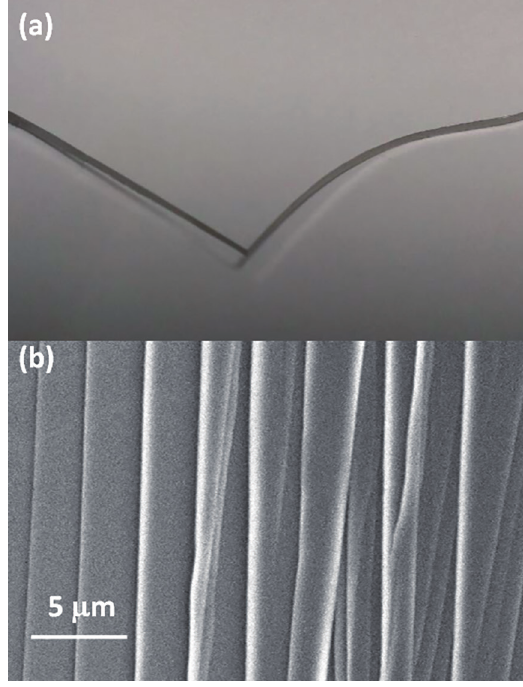
Figure 3: (a) outer surface and (b) SEM image obtained near the crease mark of the bent alloy ribbon Fe K for 600 s.